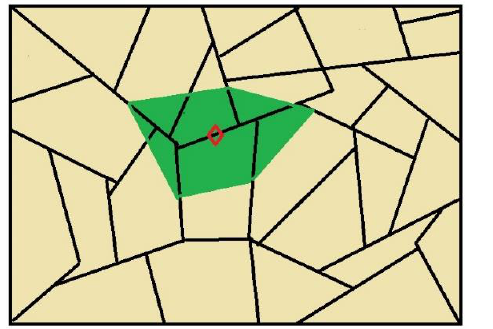
Figure3. Create Voronoi polygons around interpolation points